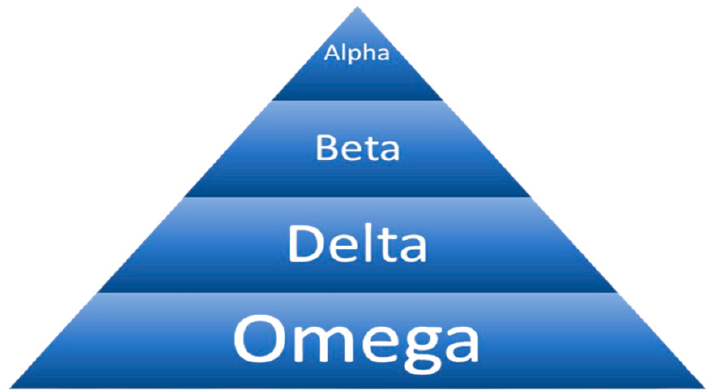
Figure 2. The hierarchy distribution of the grey wolf.